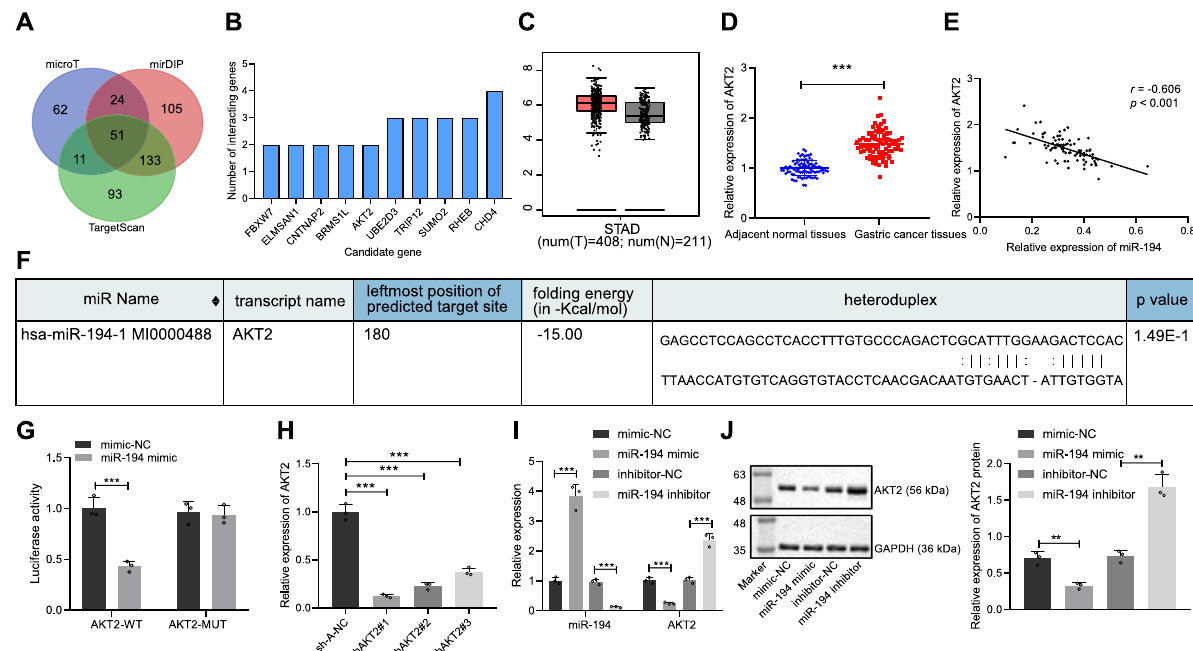
Fig. 2 AKT2 is a target of miR-194. A Venn diagram (http://bioinformatics.psb.ugent.be/webtools/Venn/) of databases of microT (http:// diana.imis.athena-innovation.gr/DianaTools/index.php?r = microT_CDS/), mirDIP (http://ophid.utoronto.ca/mirDIP/), and TargetScan (http:// www.targetscan.org/vert_72/) to predict target genes of miR-194; B correlation and interaction analysis of target genes through STRING website (https://string-db.org/). The abscissa indicates the number of interacting genes, and the ordinate indicates the names of candidate genes; C AKT2 expression in GC and normal samples in the TCGA database. The abscissa represents the sample type, T represents the GC sample, N represents the normal sample, and the ordinate represents the sample expression level; D qRT-PCR to determine the expression of AKT2 mRNA in GC tissues and adjacent normal tissues; E Correlation analysis of miR-194 expression and AKT2 level; F Prediction of the binding site between AKT2 and miR-194 through the RNA22 website (https://cm.jefferson.edu/rna22/); G Dual luciferase assay to verify the targeting relationship between AKT2 and miR-194; H qRT-PCR to measure the silencing ef fi ciency of AKT2; I qRT-PCR to determine miR-194 and AKT2 expression in each group of transfected cells; J western blot assay to determine the protein expression of AKT2 in transfected cells of each group. * p < 0.05, ** p < 0.00, *** p < 0.0001. The measurement data are summarized by mean ± standard deviation. Data in C , D were analyzed by paired t test. Data in H – J were analyzed by one-way ANOVA with Tukey post hoc test. Data in G were analyzed by two-way ANOVA with Tukey post hoc test. Pearson coef fi cient was employed to evaluate the correlation between AKT2 and miR-194. Cellular experiment was repeated three